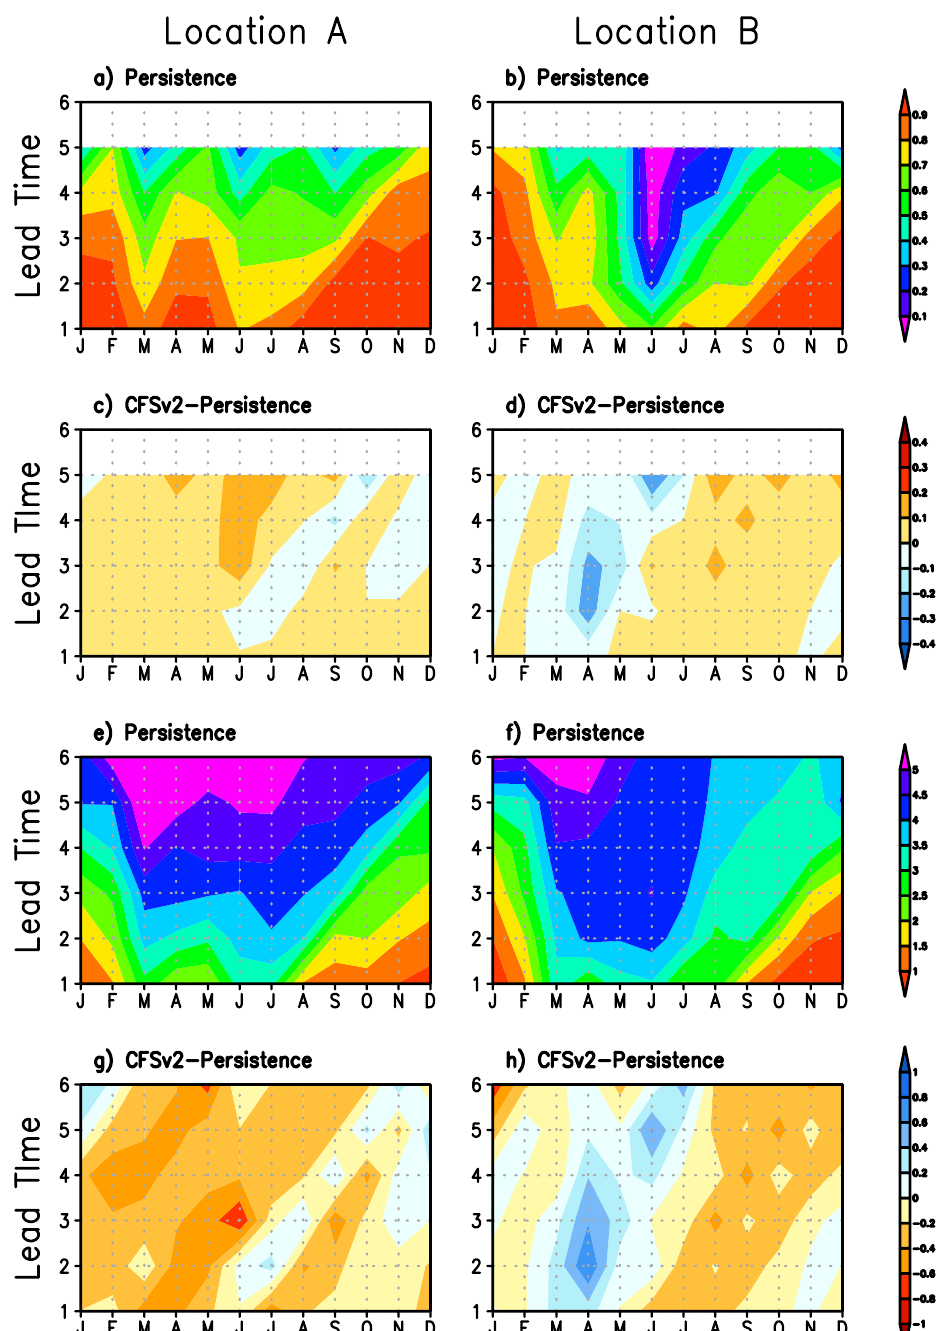
Figure 5. Variation of forecast skill in the baseline SPI6 persistence forecast (rows 1 and 3) and the changes of forecast skill in the CFSv2 forecast (rows 2 and 4) in two selected locations marked in Figure 1a to represent two distinct climate zones. The forecast skill was measured by correlation coefficient in the top two rows ( a – d ) and by the RMSE in the bottom tow rows ( e – h